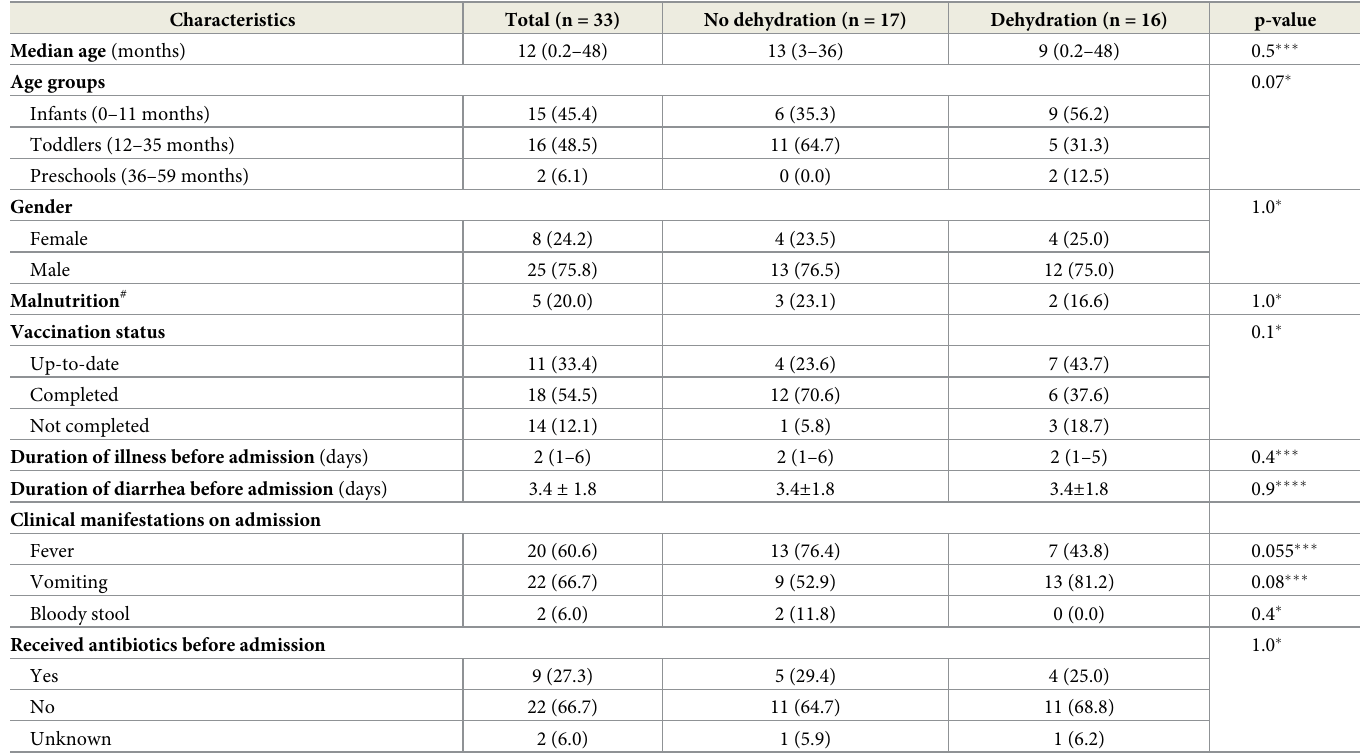
Table 1. Demographic and clinical